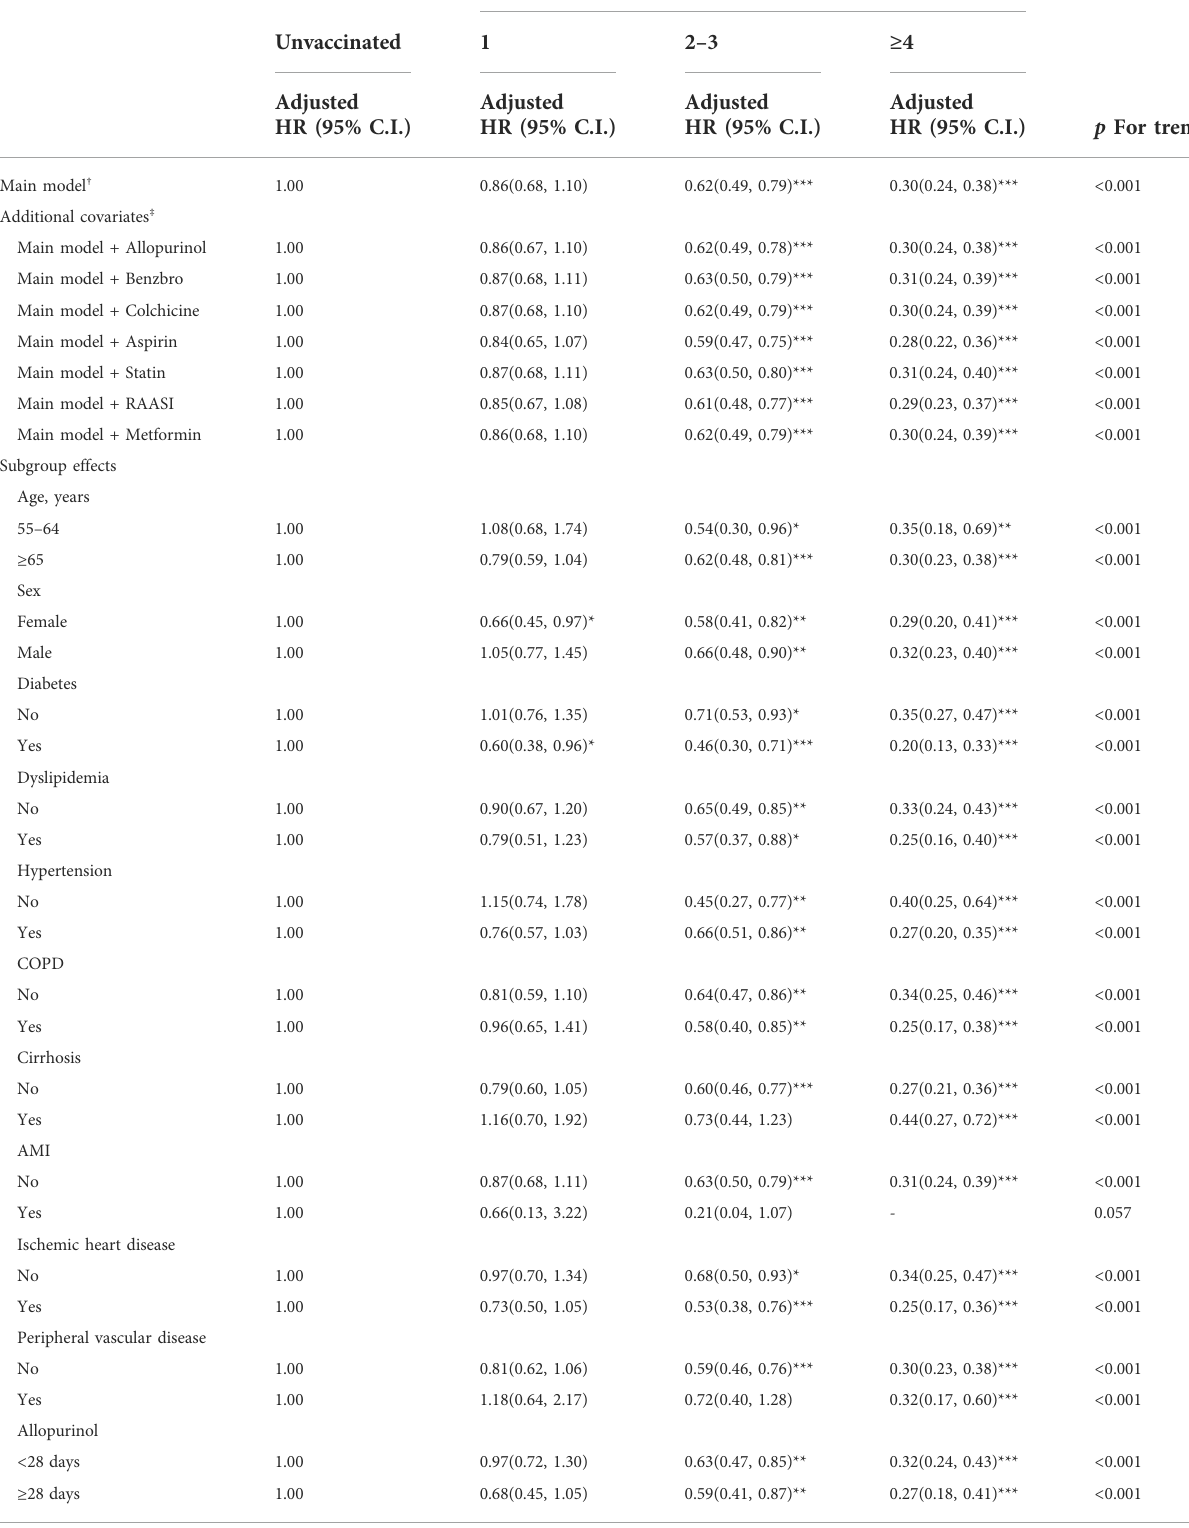
TABLE 4 Sensitivity analysis of adjusted HRs of vaccination in risk reduction of atrial fi brillation in non-in fl uenza